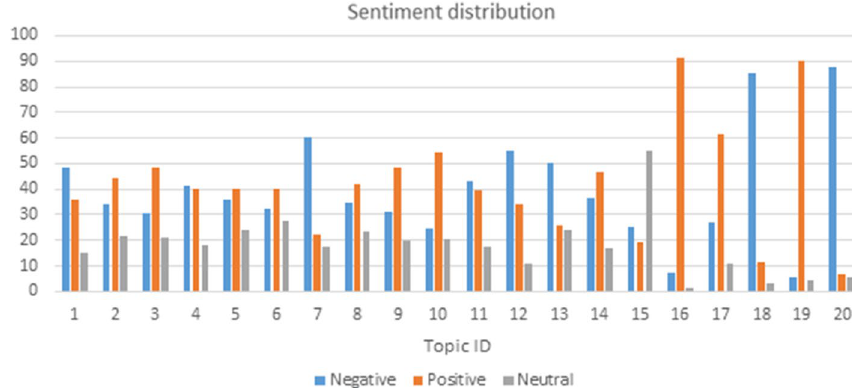
Fig. 5 Sentiment distribution in ASD COVID-19 topics during 2020